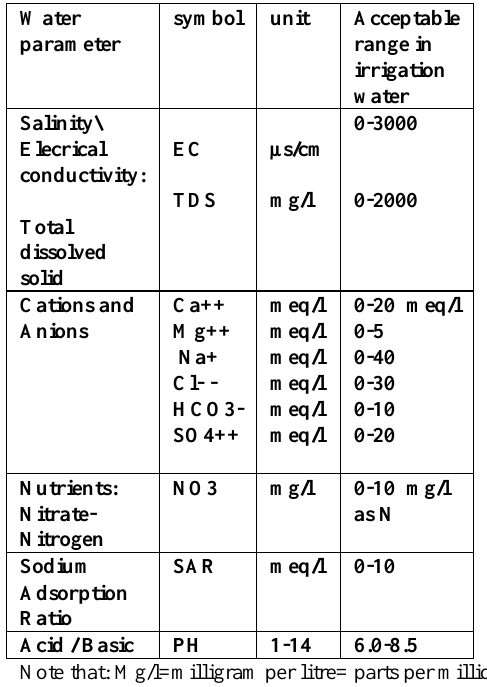
Fig (13) Khartoum State GWWR Sodium Absorbtion Ratio (SAR). The evaluation of ground water quality and it sutablity for irrigation using distribution of SAR , indicating that 98%of wells suitable for irrigation with SAR less than 10 see (fig 12),and only few wells with SAR more than 10 found in area south